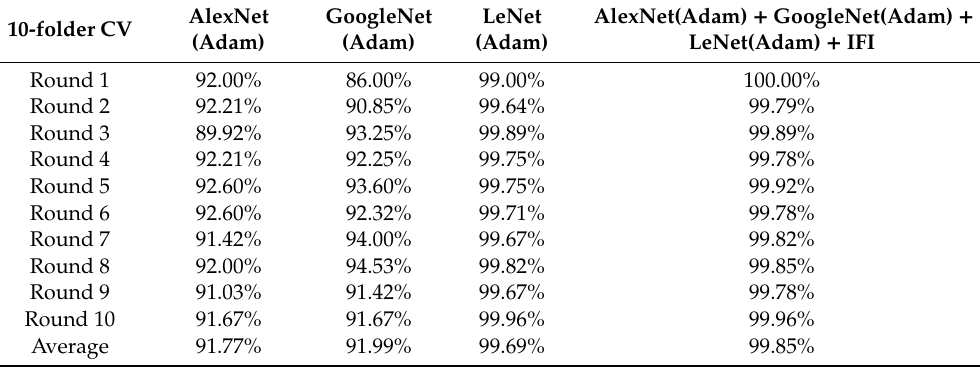
Table 2. Recognition results of di ff erent architectures with Adam optimization method.